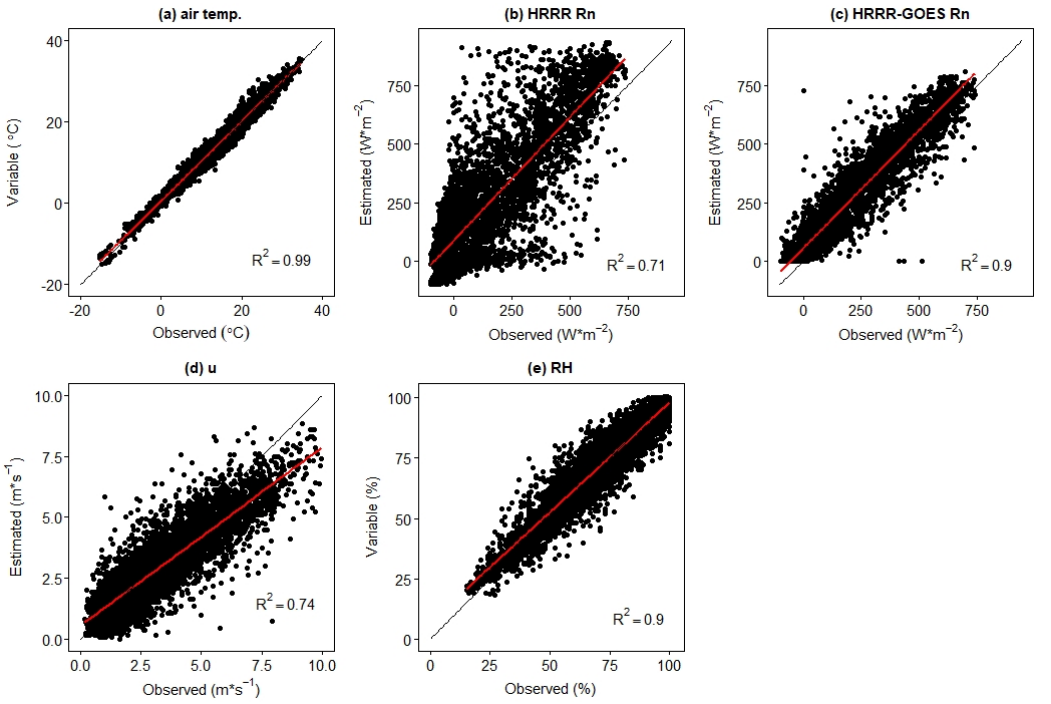
Figure 4. Scatter plots of observed vs. modeled actual evapotranspiration (AET) in the hourly time scale for Tower 10 ( A ) and Tower 11 ( B ) between May 2016 and April 2017. A black solid line indicates 1:1 line and a blue solid line represents a linear regression line.